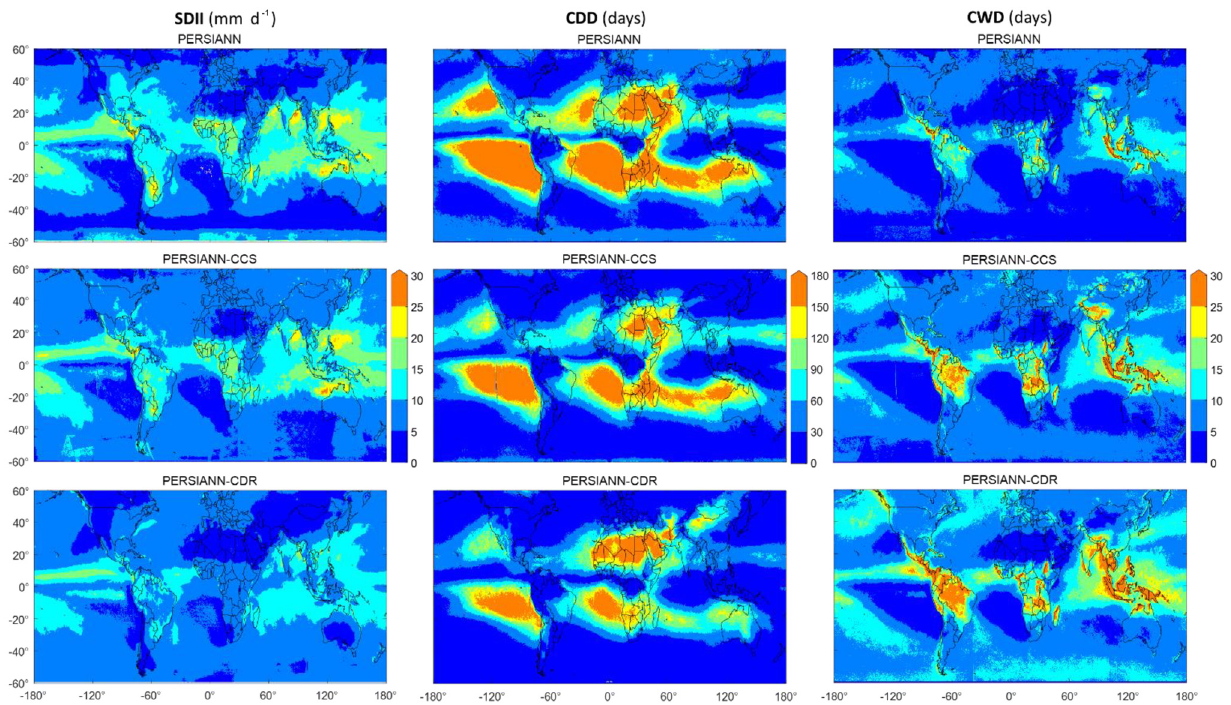
Figure 10. Extreme precipitation indices (SDII, CDD, and CWD) for PERSIANN, PERSIANN-CCS, and PERSIANN-CDR over the globe. (See Table 4 for definitions of the indices.)